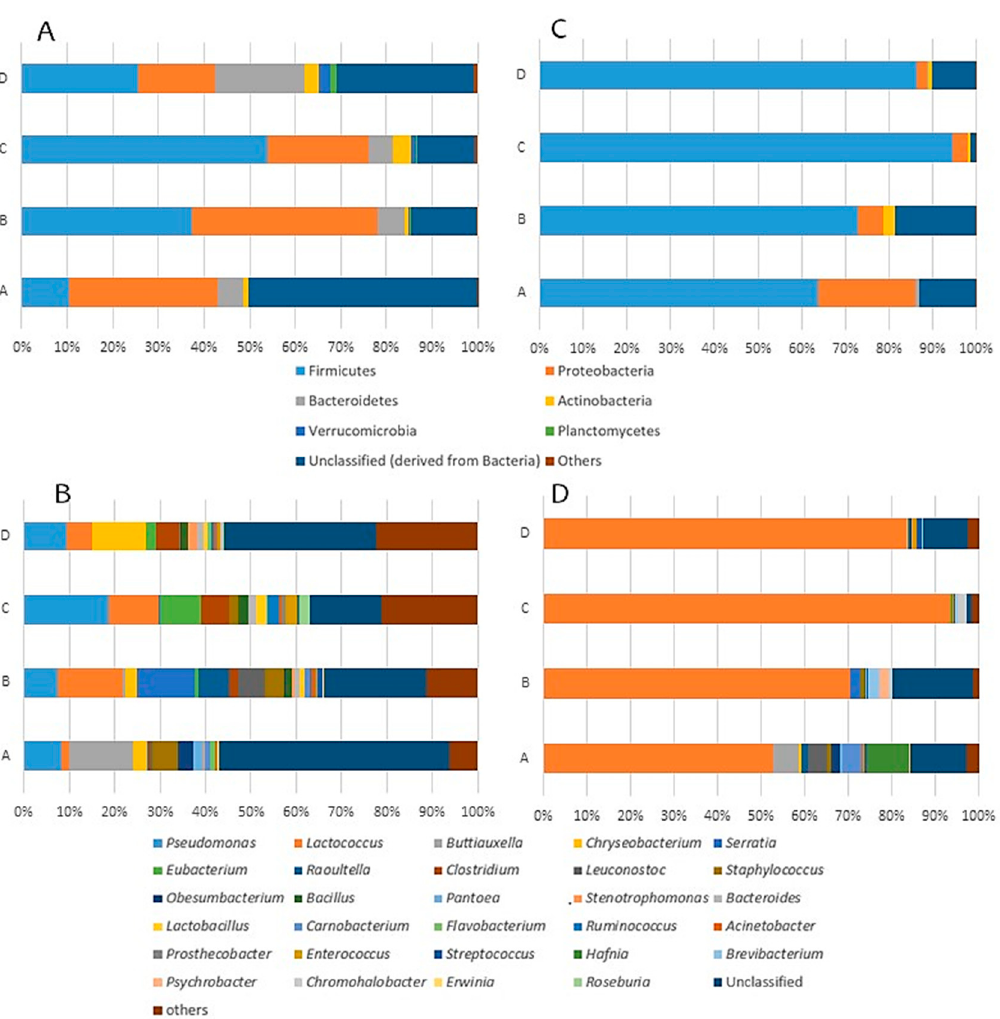
Figure 1. Relative abundance (%) of bacterial phyla and genera of Latxa ewe raw milk (( A , B ), respectively) and 1-day-old ripened Idiazabal cheese samples (( C , D ), respectively) produced by four producers (A, B, C, D).